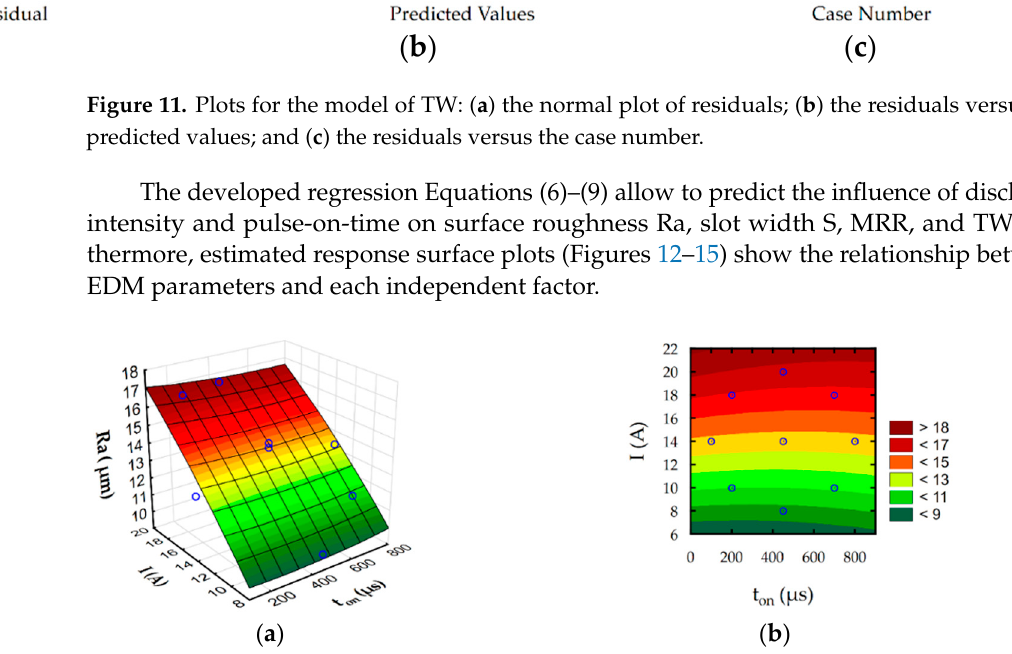
Figure 12. Estimated for roughness Ra: ( a ) response surface and ( b ) contour plot.